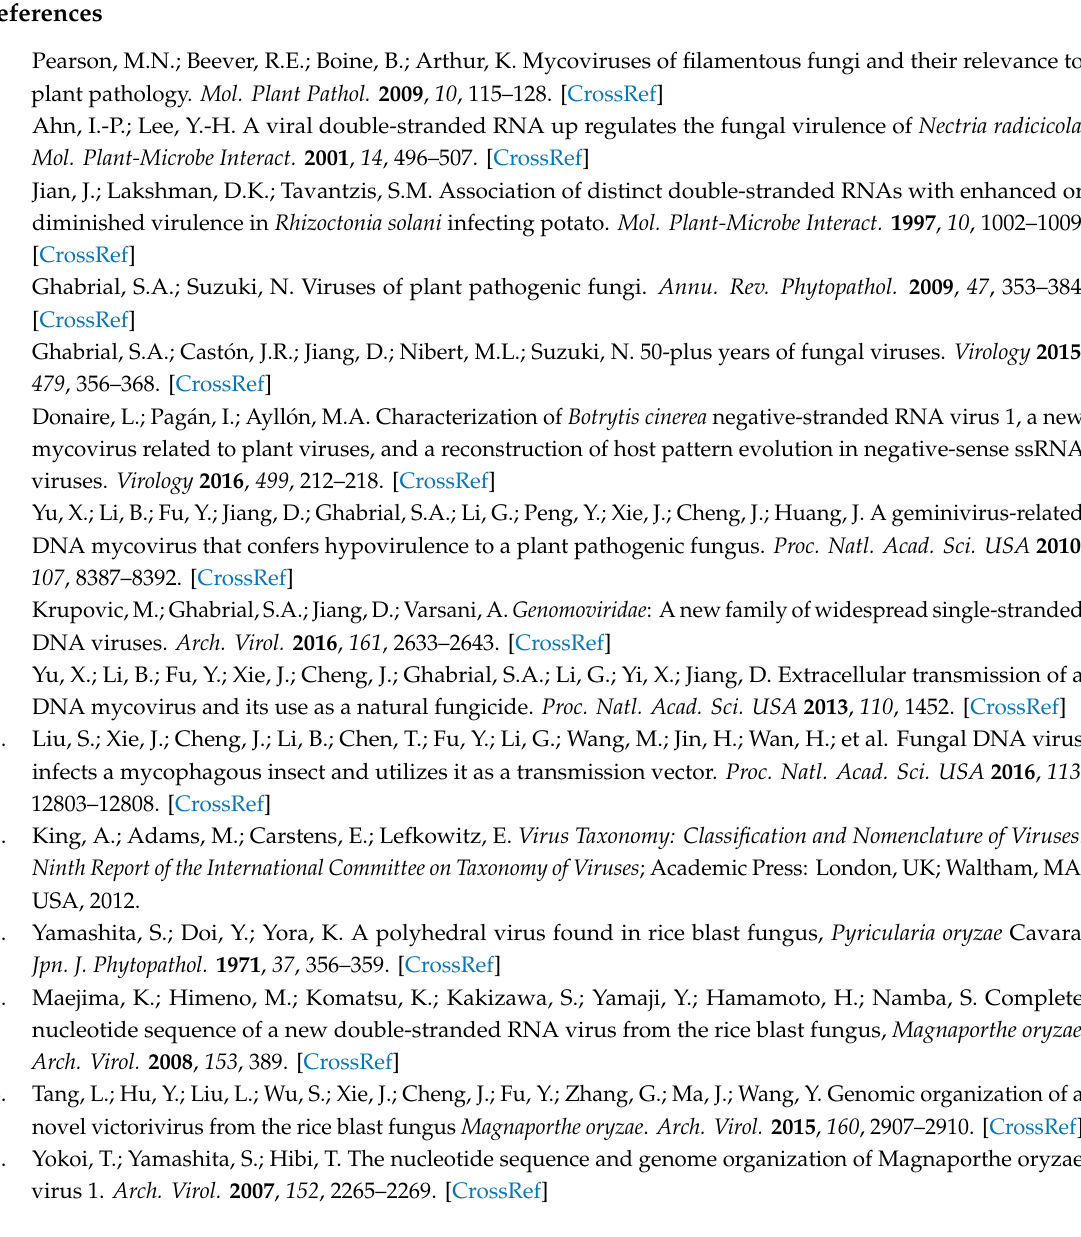
Table S1: The primers used in the